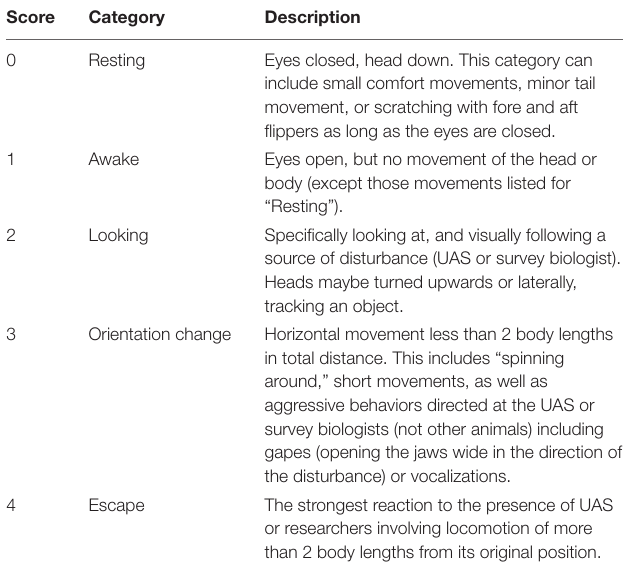
TABLE 3 | Ethogram describing the five levels of behavioral response scores assigned by independent observers based on photographs of Antarctic fur seals ( n = 4,734) or leopard seals ( n = 621).